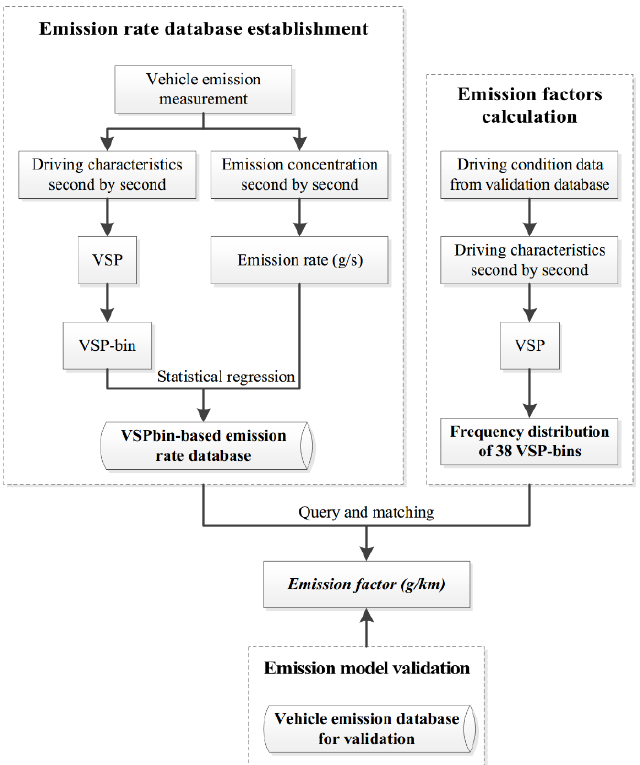
Figure 2. The technical route of the development of emission factor model based on driving condi- tion.